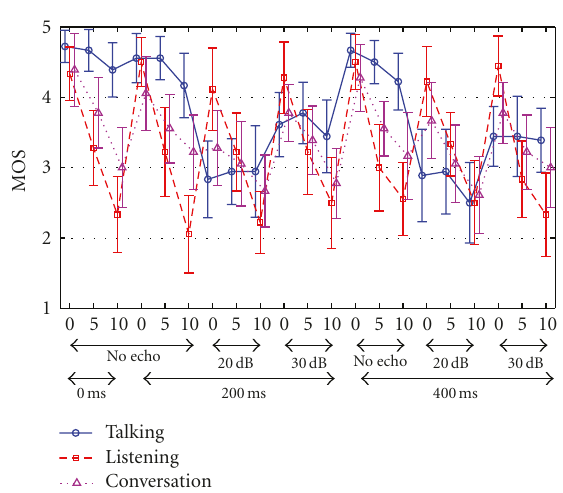
Figure 8: Echo, delay, and packet loss test results.